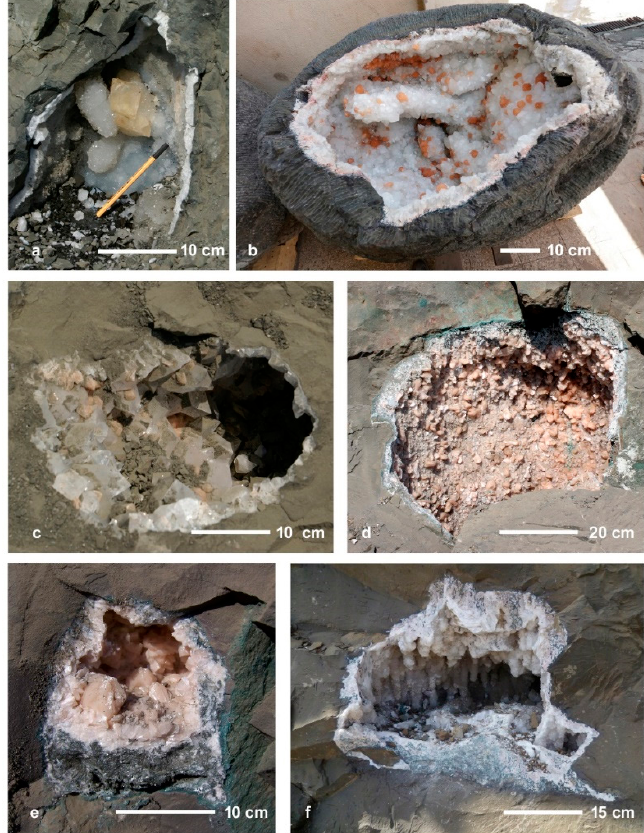
Figure 3. Cavities from the core line in Savda representing different shapes and sizes. The secondary minerals are chalcedony, calcite, stilbite, apophyllite, and minor heulandite. ( a ) arched roof, ( b ) big cavity with flat bottom, ( c ) round shape, ( d ) upward convex, skirted shape, ( e ) flat bottom, and ( f ) flat bottom, upward convex skirted shape.